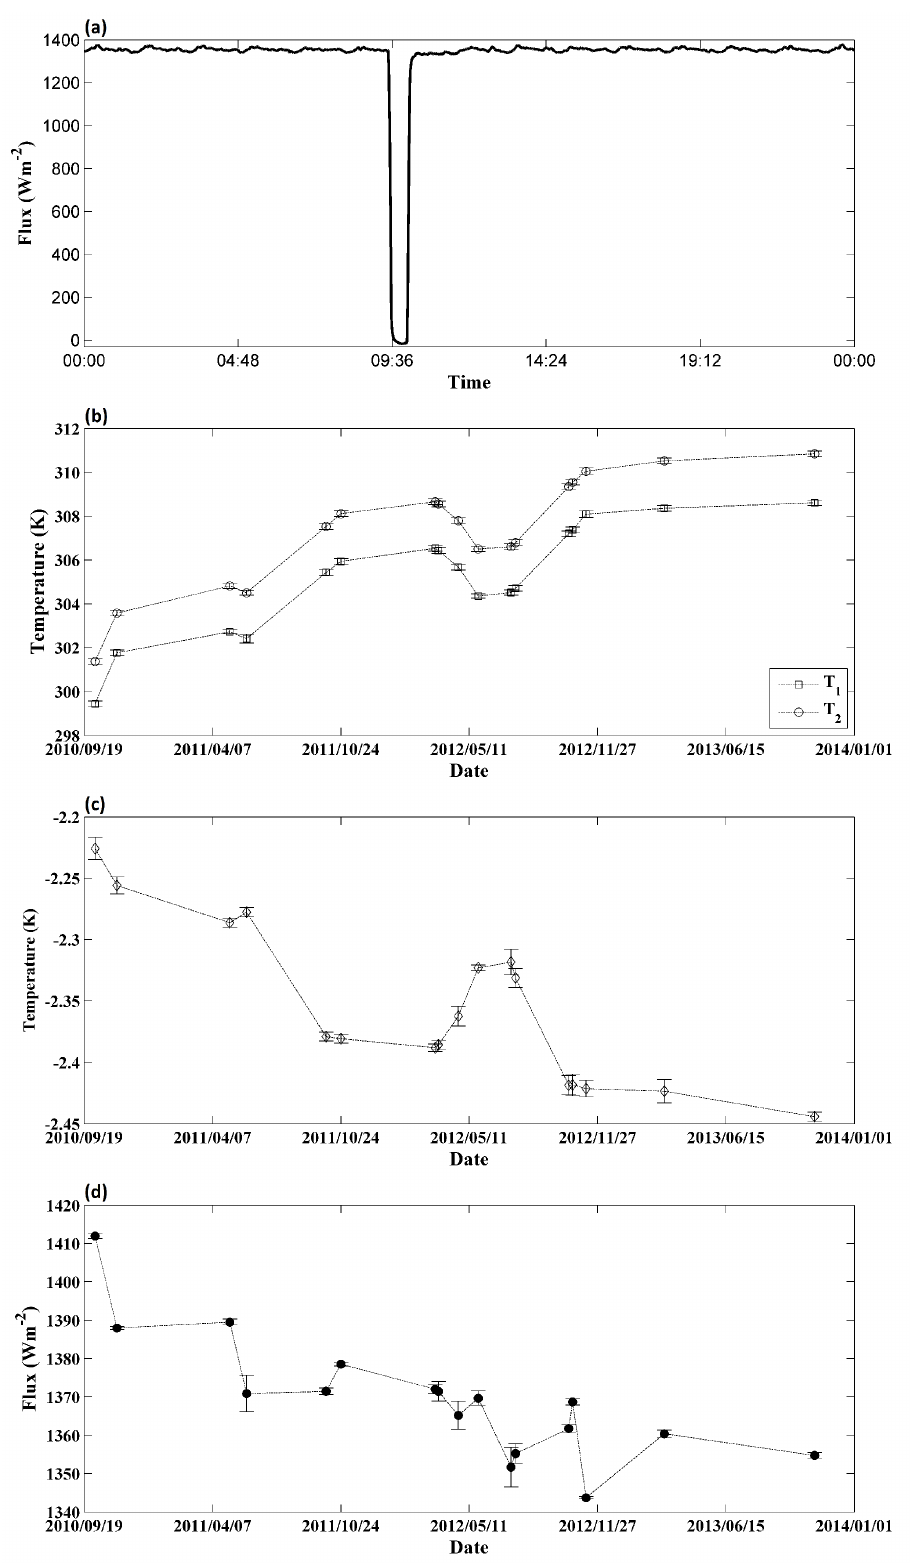
Figure 5. Star-pointing events (MES) observed in space. (a) One example of MES events. (b) T 1 and T 2 of all MES. (c) The temperature difference ( T 1 − T 2 ). (d) The calibrated flux; it has been normalised to